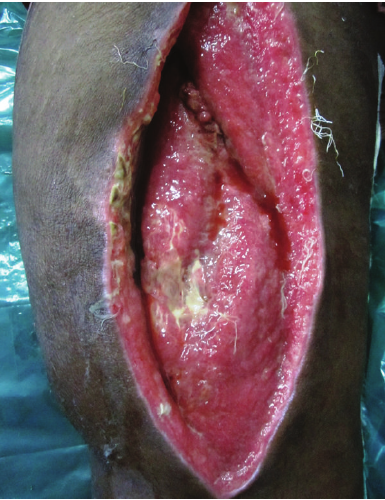
Figure 4: Wound after debridement—granulating wound on right thigh (anterior view).